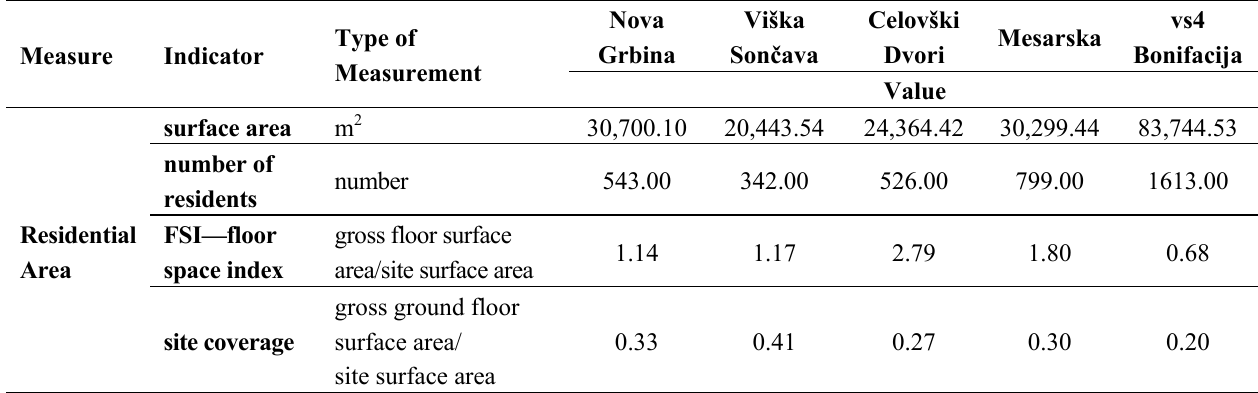
Table 1. Evaluation of residential areas: spatial mesaure “residential area”, described by different indicators.